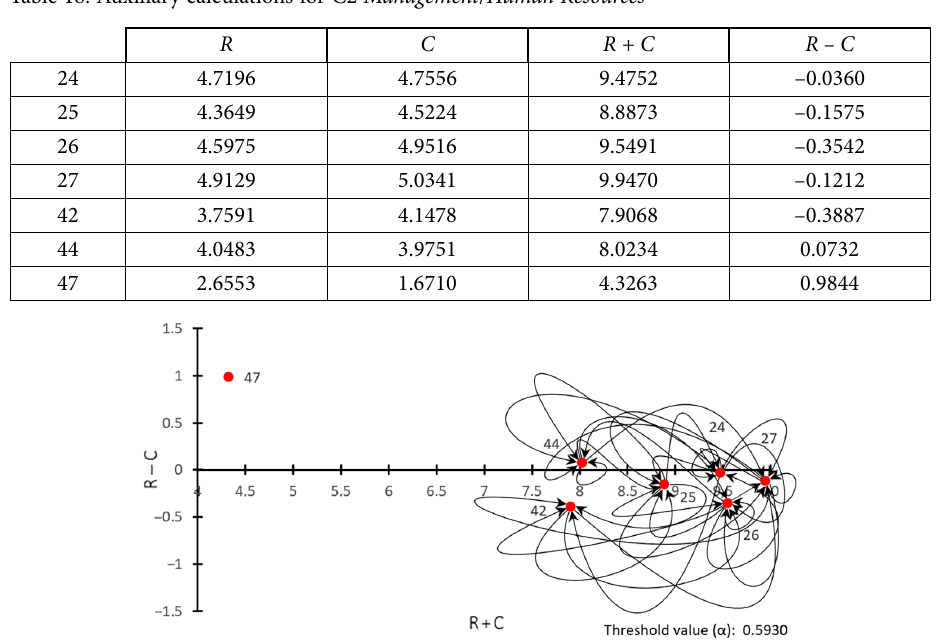
Figure 4. DEMATEL relationships diagram for C2 Management / Human